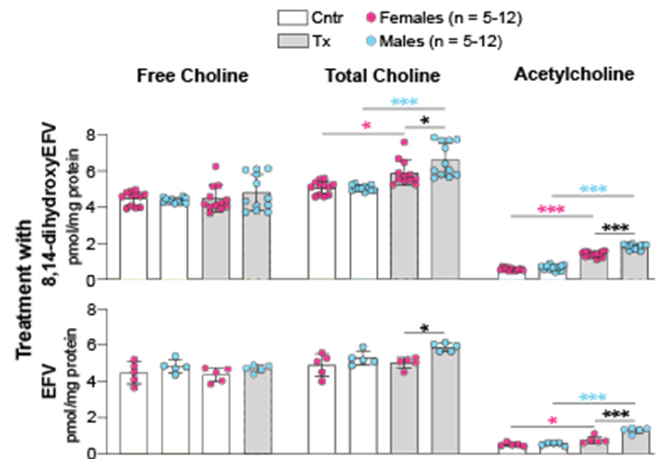
Figure 5. 8,14-DihydroxyEFV and EFV effects on the brain Ach levels. Data represent the mean ± SD of the measurements in individual mice (5–12 female mice and 5–12 male mice). *, p ≤ 0.05; ***, p ≤ 0.001 as assessed by two-way ANOVA with Tukey’s multiple comparison test. The asterisk color indicates significance between female mice (pink), male mice (blue) or male-female animals (black). Cntr, control mice; Tx, treated mice.